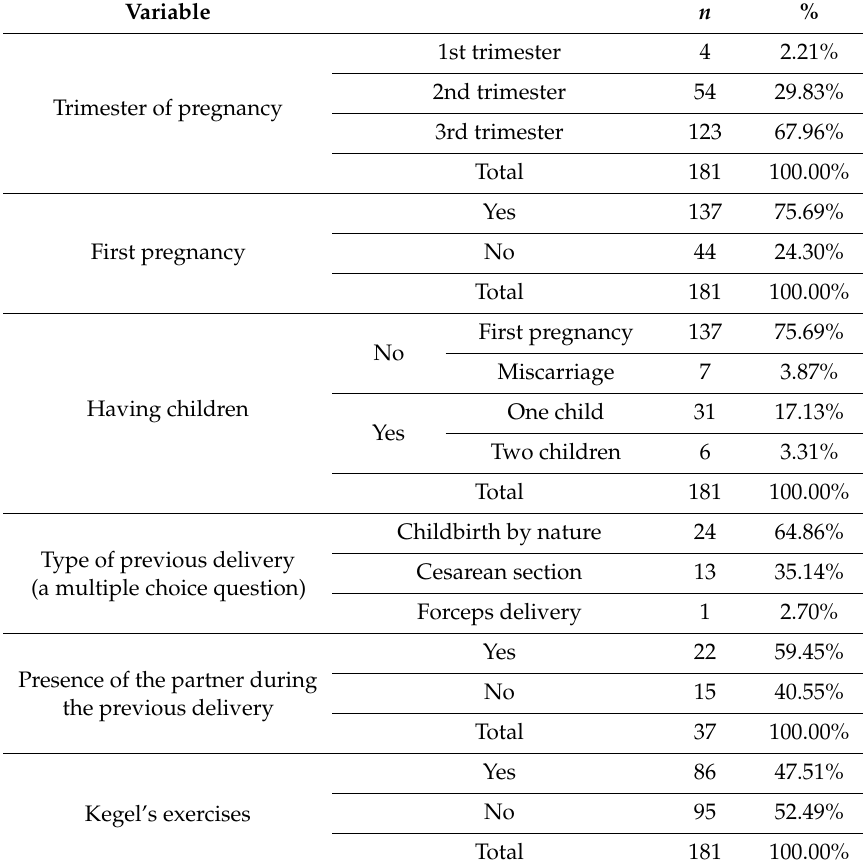
Table 2. Pregnancy data.